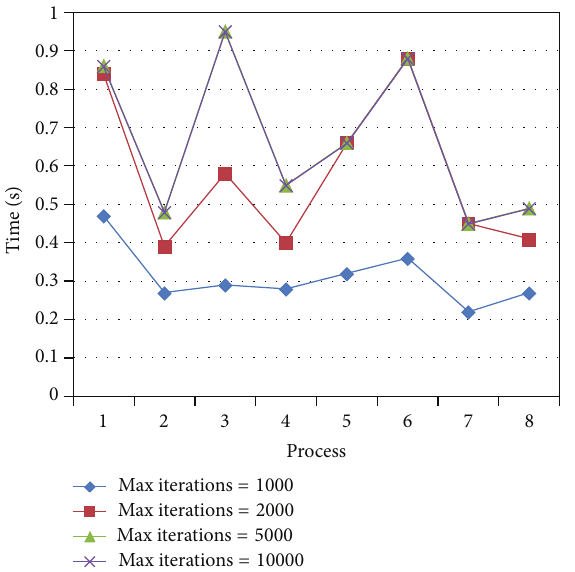
Figure 3: Comparison of different maximum iterations.